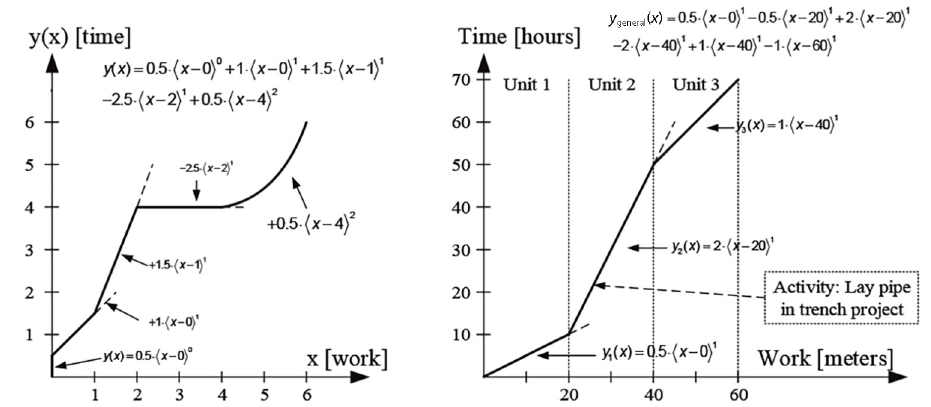
Figure 2. Example of